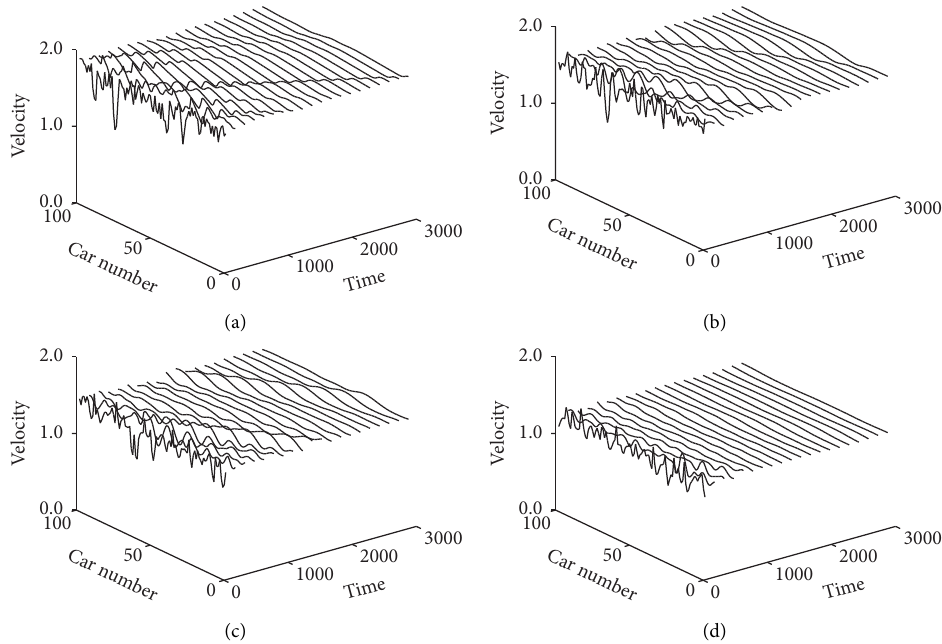
Figure 3: Temporal and spatial velocities when t